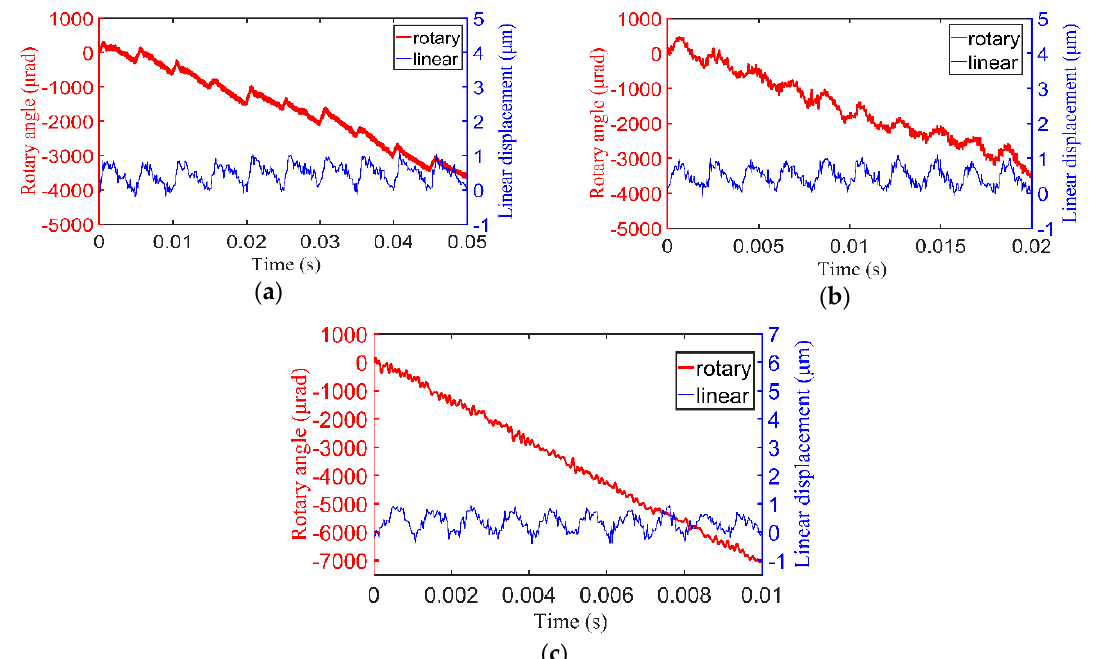
Figure 7. The output motions of the prototype motor under different driving frequencies: ( a ) 200 Hz; ( b ) 500 Hz; ( c ) 1 kHz.